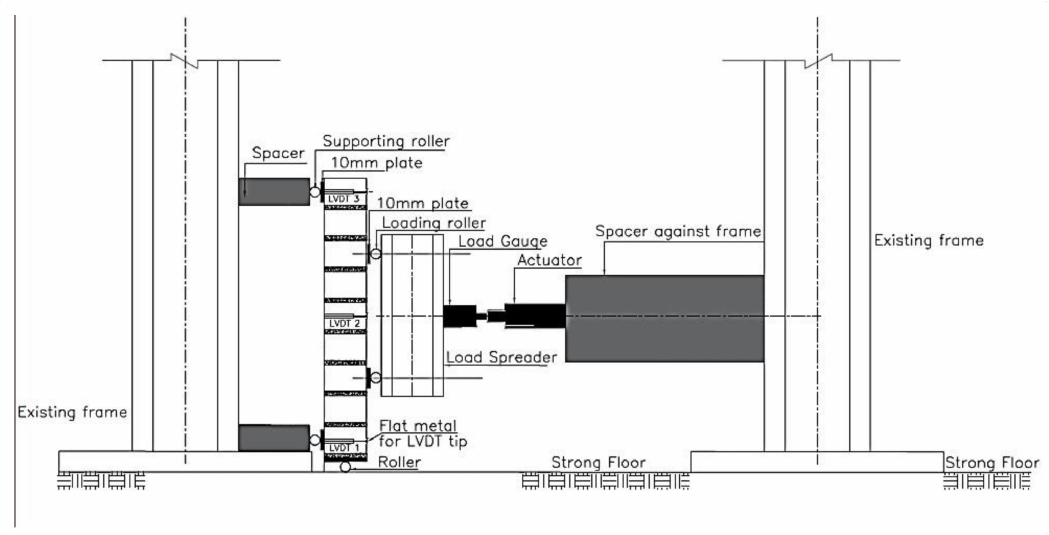
Figure 5. Small-scale test